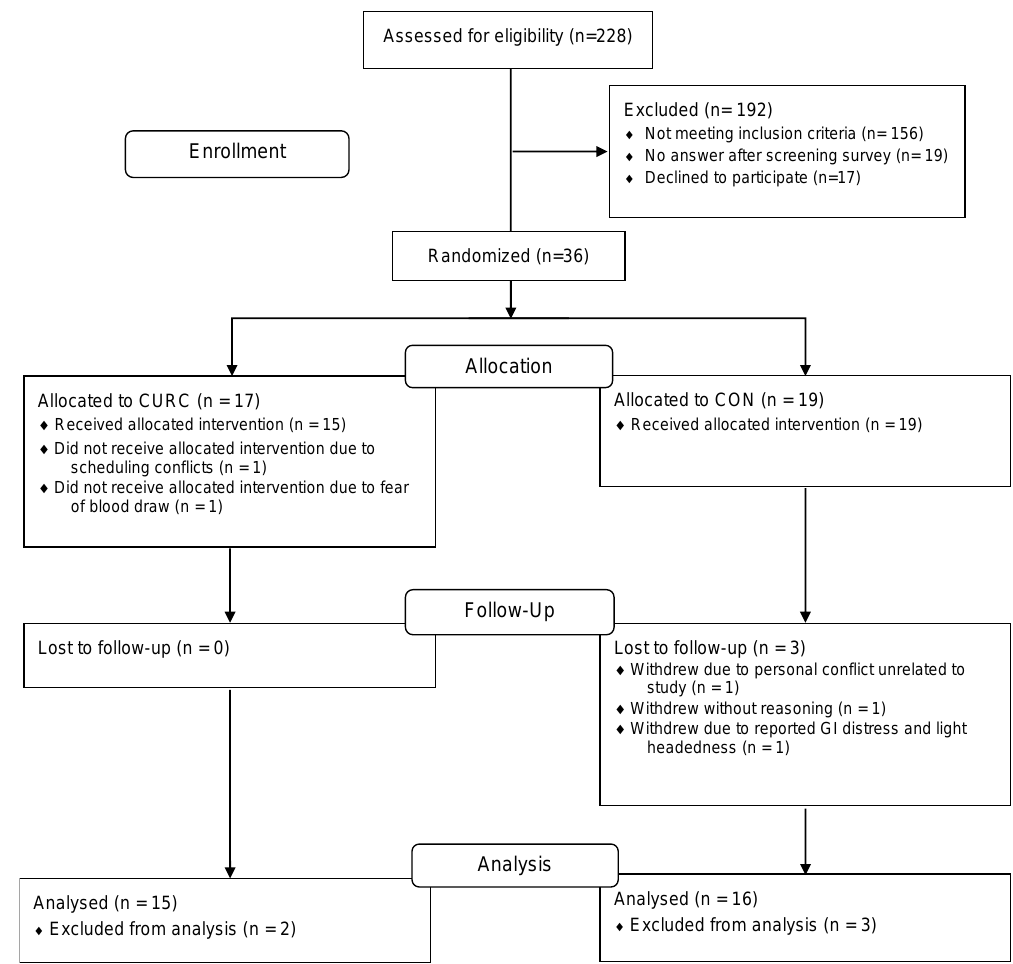
Figure 1. CONSORT flow diagram of study participants.